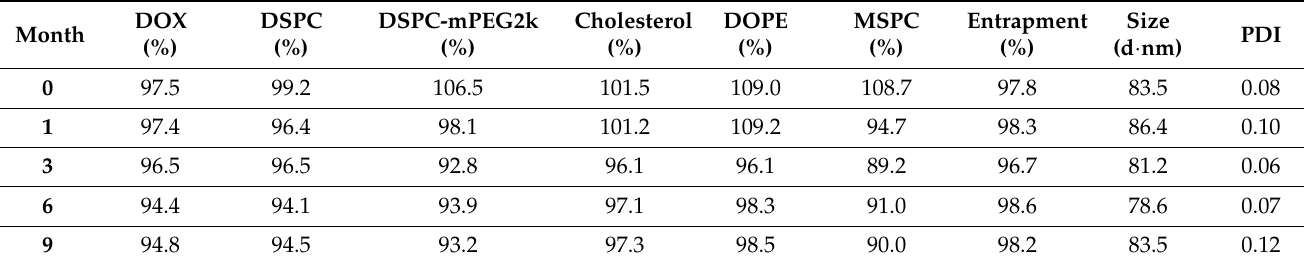
Table 1. Doxorubicin content, lipid content, entrapment, size, and PDI of IMP301 during 9 months of storage at 2 – 8 °C.